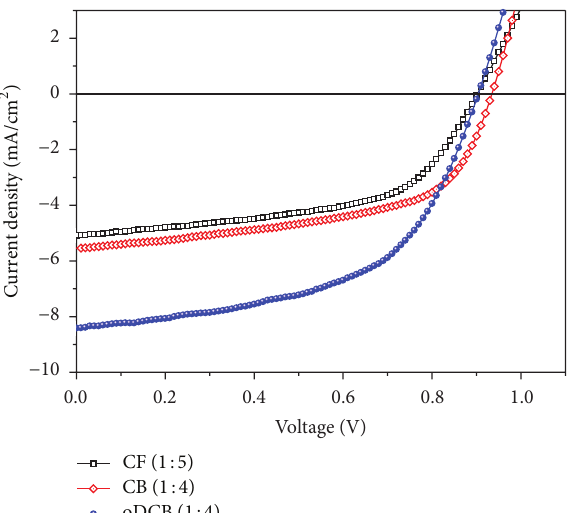
Figure 6: Current density ( J )–voltage ( V ) characteristics of ITO/PEDOT: PSS/PCDTBT: PC 71 BM/Al devices with an active layer prepared by using organic solvents of chloroform (D/A; 1:5), chlorobenzene (D/A; 1: 4), and o-dichlorobenzene (D/A; 1: 4).